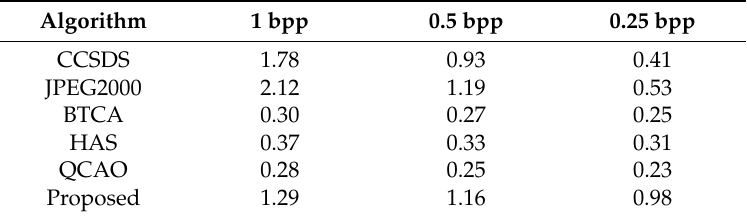
Table 6. The encoding times(s) of different compression methods.